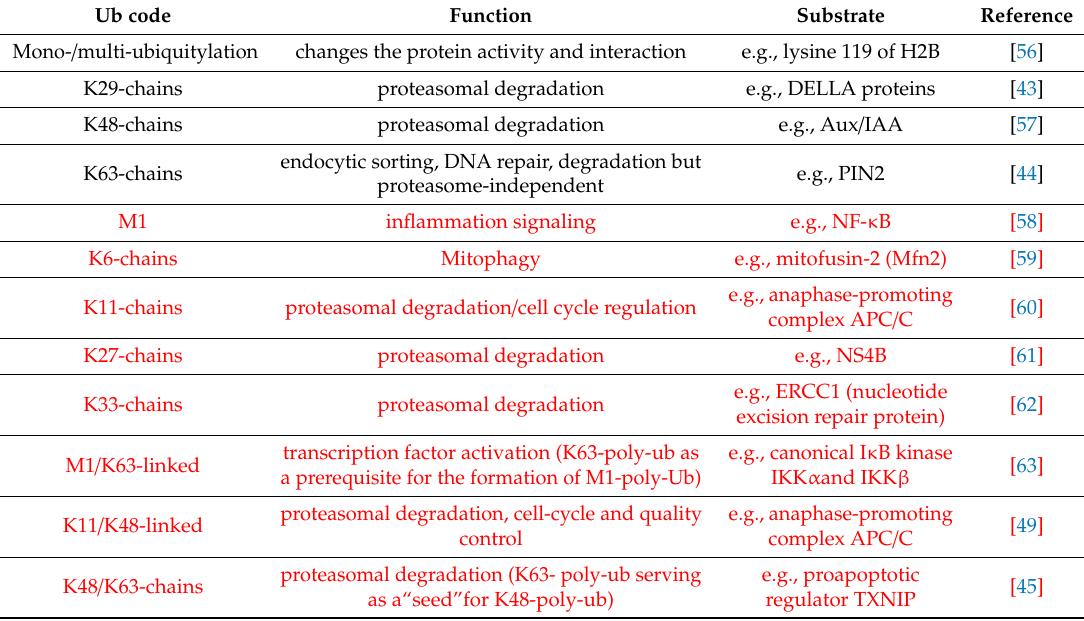
Table 1. Potential function of various ubiquitin linkage (The red ones have not been recorded in